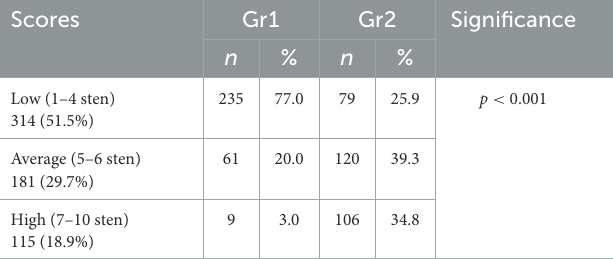
TABLE 5 Scores for satisfaction with life (SWLS) after conversion to sten